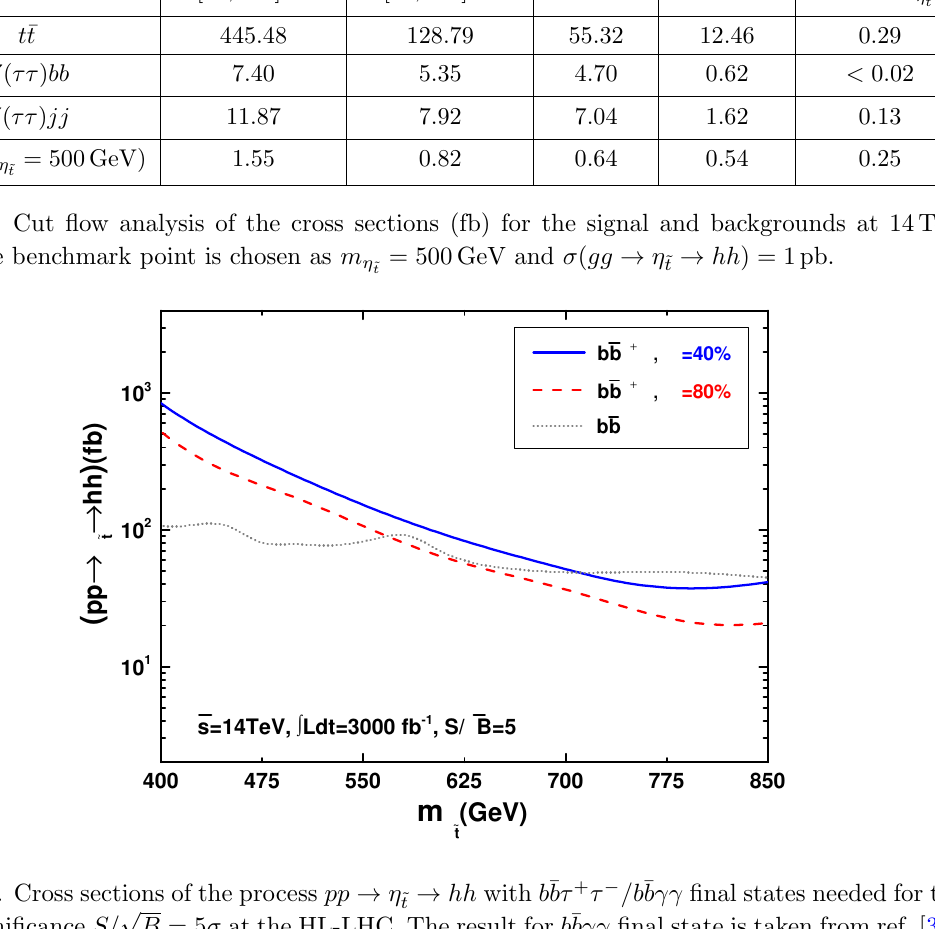
Figure 4 . Cross sections of the process pp ! (cid:17) ~ ! hh with b (cid:22) b(cid:28) + (cid:28) (cid:0) =b (cid:22) b(cid:13)(cid:13) (cid:12)nal states needed for the p t signal signi(cid:12)cance S= B = 5 (cid:27) at the HL-LHC. The result for b (cid:22) b(cid:13)(cid:13) (cid:12)nal state is taken from ref.